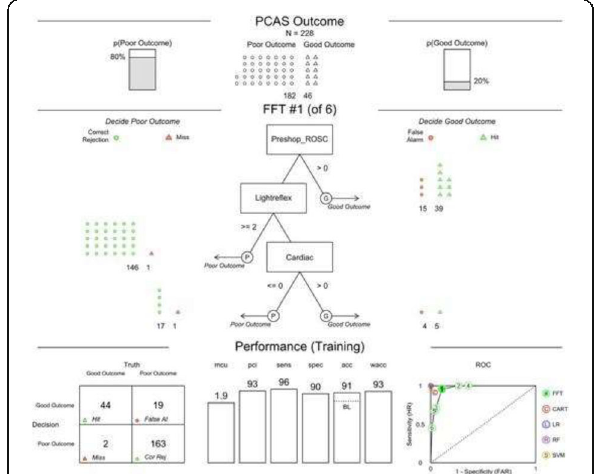
Fig. 1 (abstract 0307). Training FFT for Prediction of Neurologic Outcome